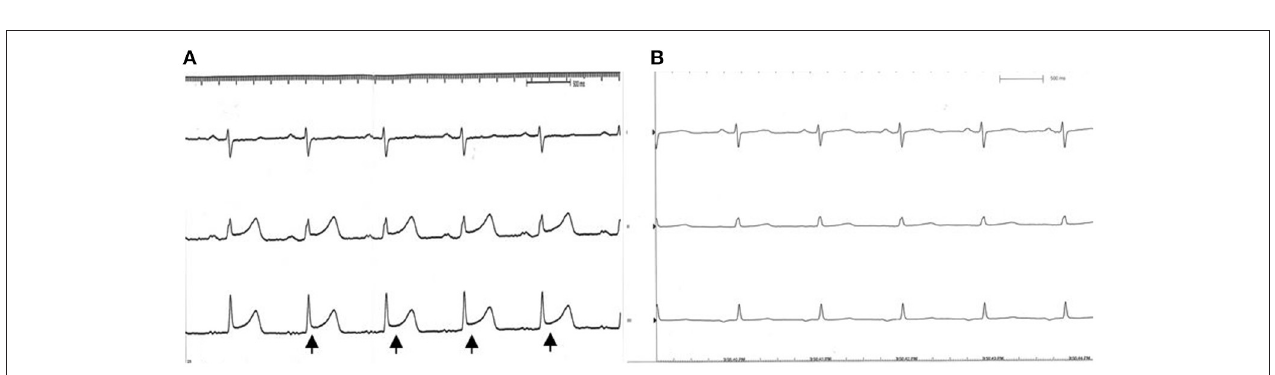
FIGURE 3 | EKG during catheterization. (A) ST segment elevation (black arrow) is noted while the coronary sinus was obstructed by the occluder. (B) Recovery to sinus rhythm after we withdrew the device.